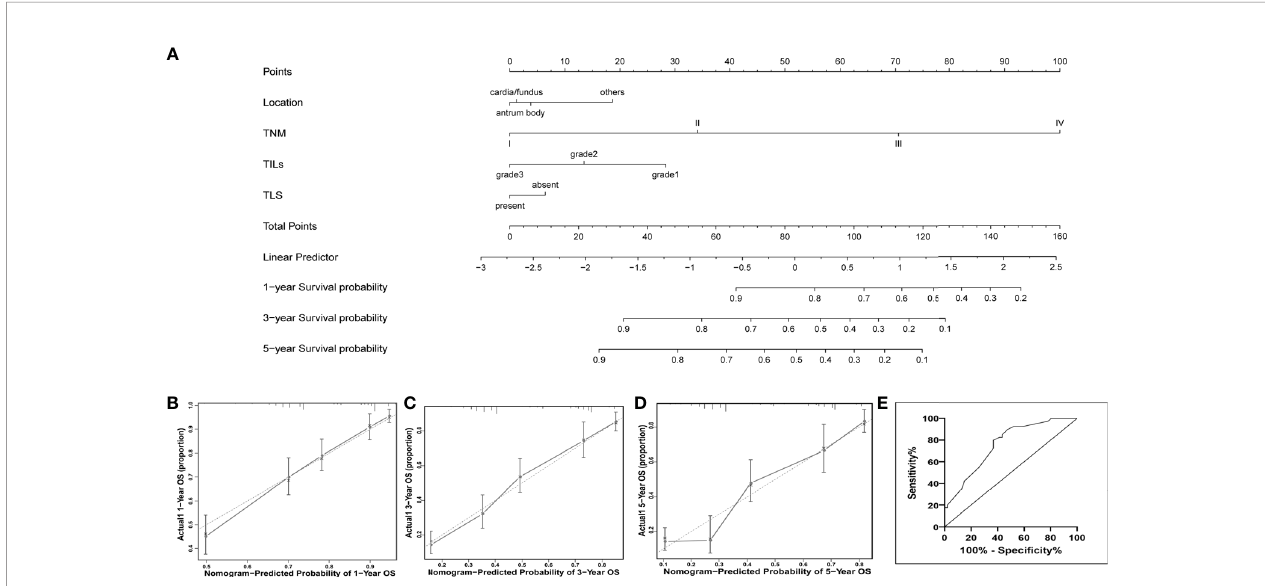
FIGURE 3 | Nomogram for predicting prognosis in patients with EBVnGC. (A) A predictive nomogram for 1-year, 3-year, and 5-year overall survival was generated by combining signi fi cant independent prognostic factors including location, TNM stage, TILs, and TLS. To estimate the survival in a given patient, the “ Total Points ” score is calculated by summing the respective “ Points ” values corresponding to each variable. Using this “ Total Points ” score, the survival probabilities at 1, 3, and 5 years can be predicted according to the lower scales. Calibration plots of the nomogram for 1-year (B) , 3-years (C) , and 5-years (D) overall survival. Dotted Line, ideal model; vertical bars, 95% con fi dent interval. (E) Predictive accuracy of the nomogram for overall survival were con fi rmed in the external validation cohort, indicating the model was